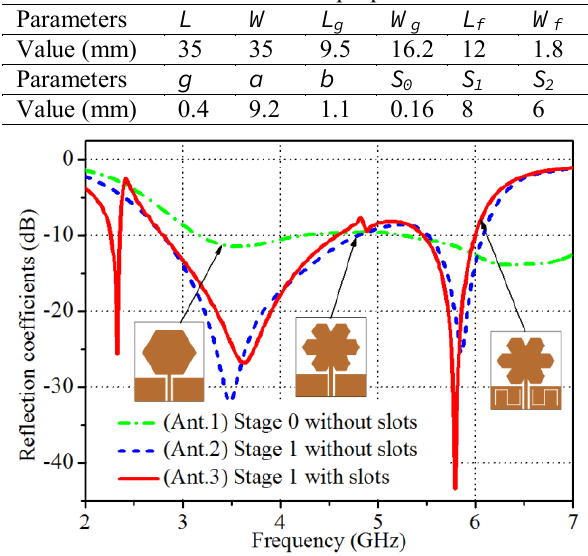
Figure 4: Simulated reflection coefficients of the different proposed stages.